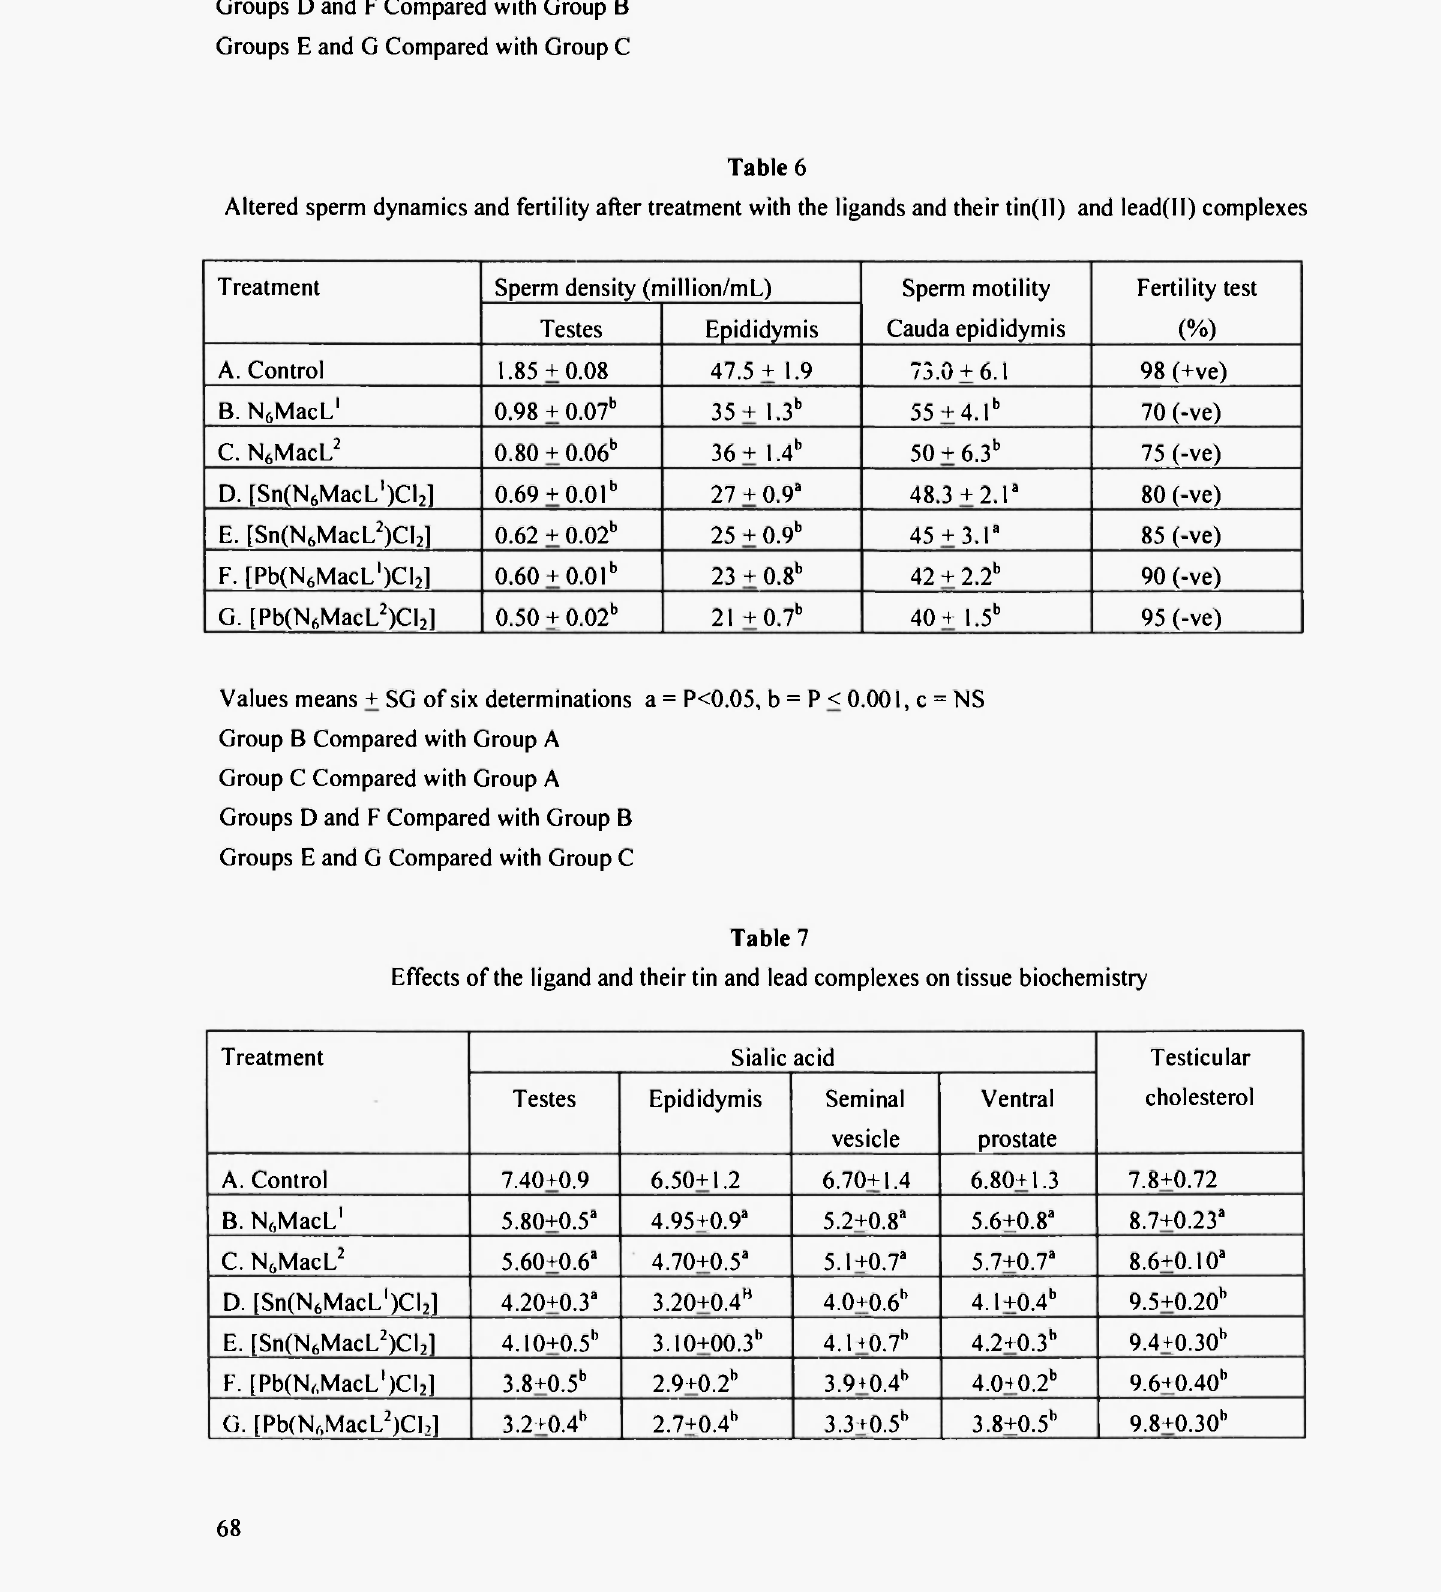
Effects of the ligand and their tin and lead complexes on tissue